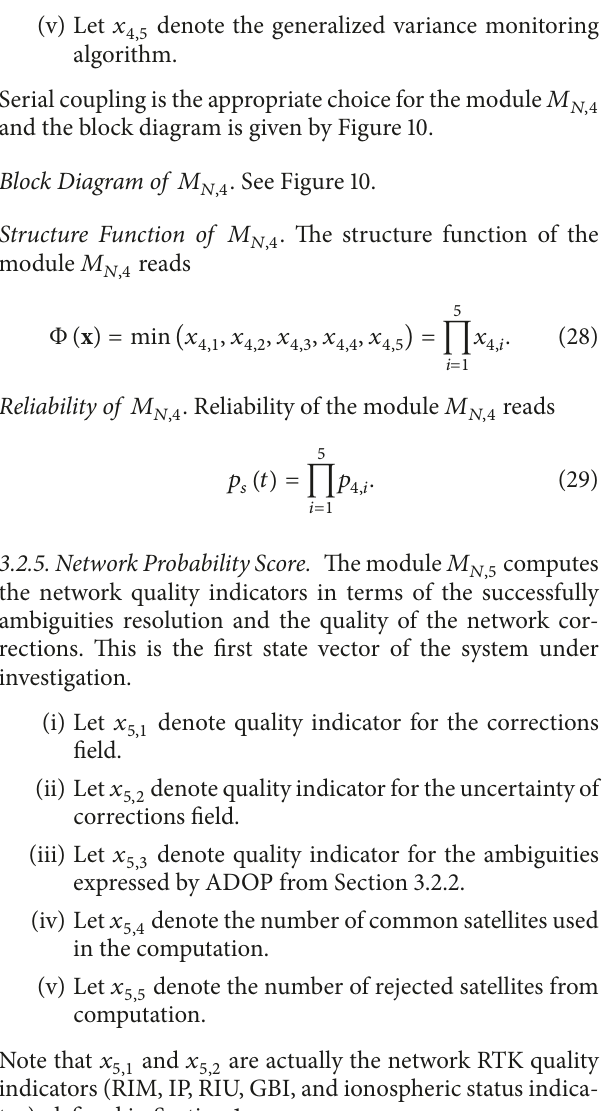
Figure 11: Block diagram of module 𝑀 𝑁,5